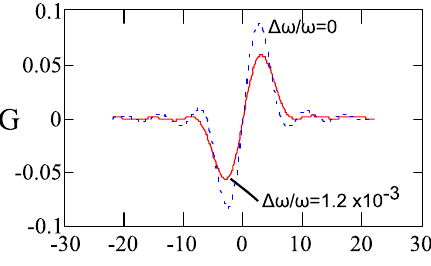
FIG. 2. Gain function G ð ν 1 ; ν 2 Þ , derived from Eq. (1), versus the detuning parameter, for Δ ω = ω ≅ 1 . 2 × 10 − 3 (continuous line) and Δ ω = ω ≅ 0 (dotted line), g 0 ¼ 0 . 1